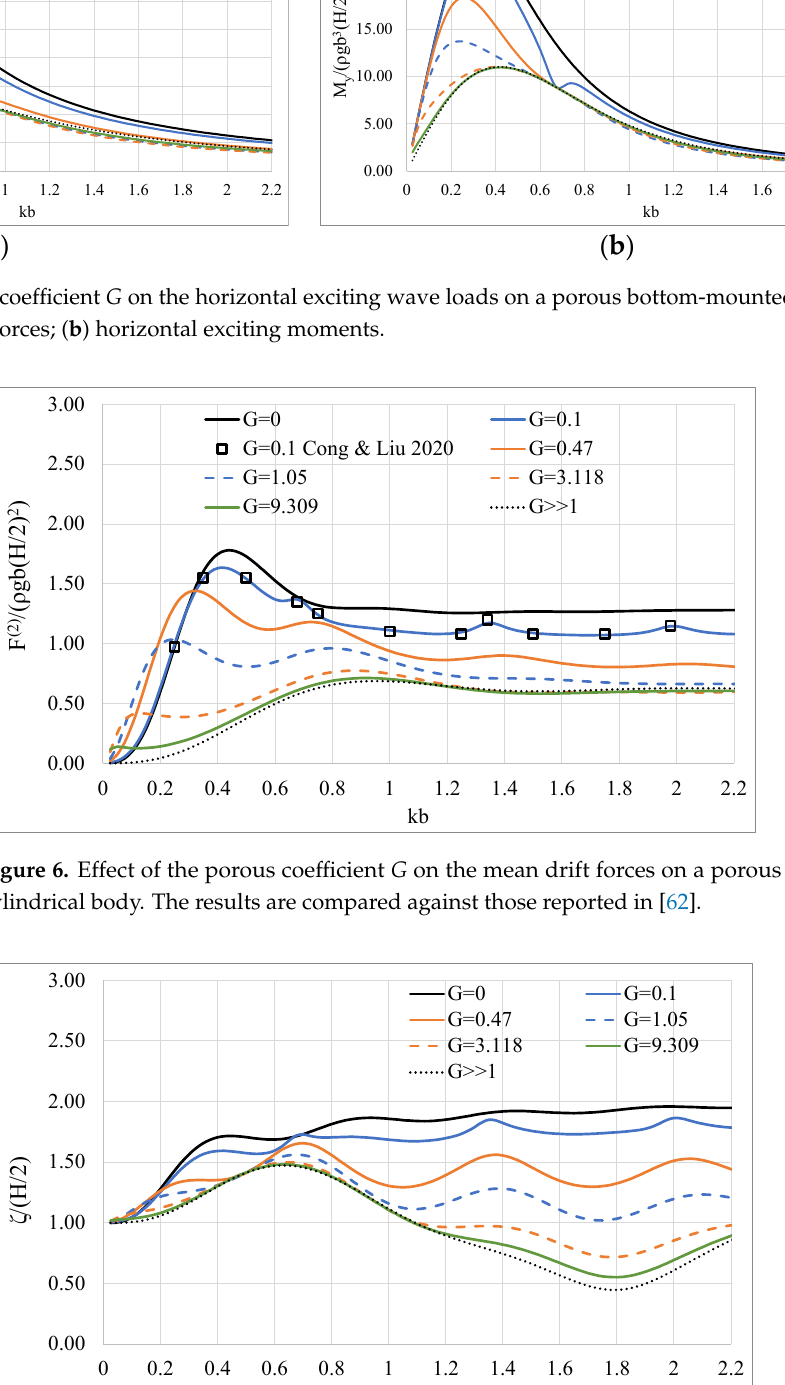
Figure 7. Effect of the porous coefficient 𝐺 on the wave run up of the porous cylindrical system.